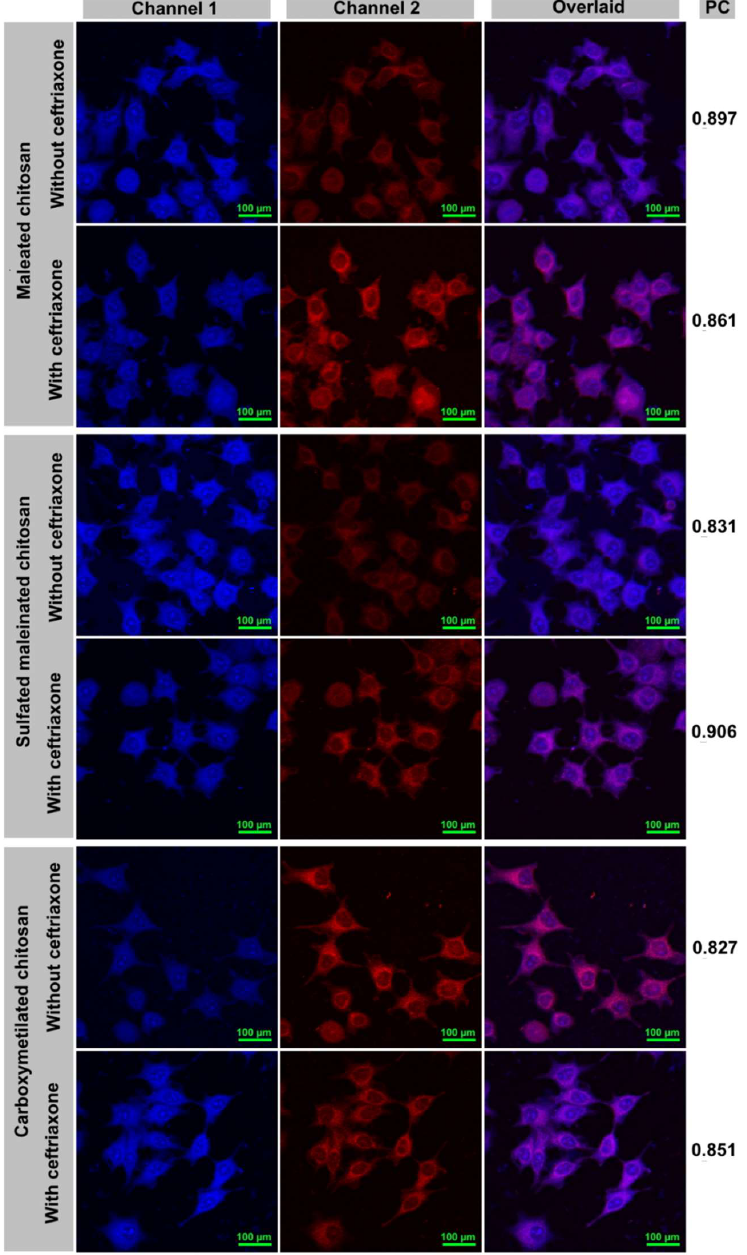
Figure 10. CLSM images of the aggregates dye–PHMG and dye–ceftriaxone–PHMG encapsulated into different chitosan types endocytosed into cells. For each sample, images from left to right show: channel 1 ( λ ex = 515 nm), channel 2 ( λ ex = 635 nm), and the overlay of the two images. PC: pearson’s colocalization coefficient.